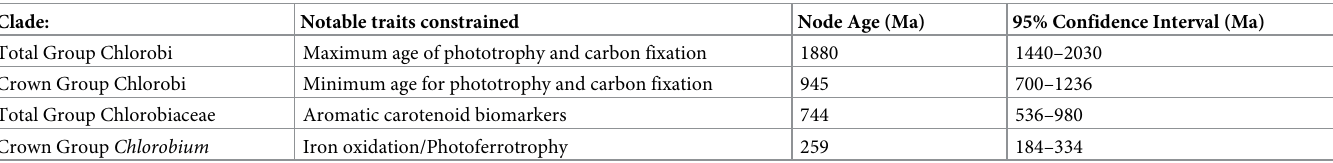
Table 1. Molecular Clock estimates for key clades based on T03 constraints. Clade: